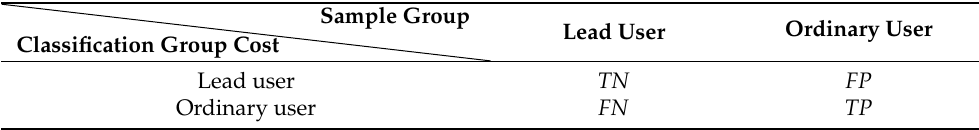
Table 3. Confusion matrix of identifying lead